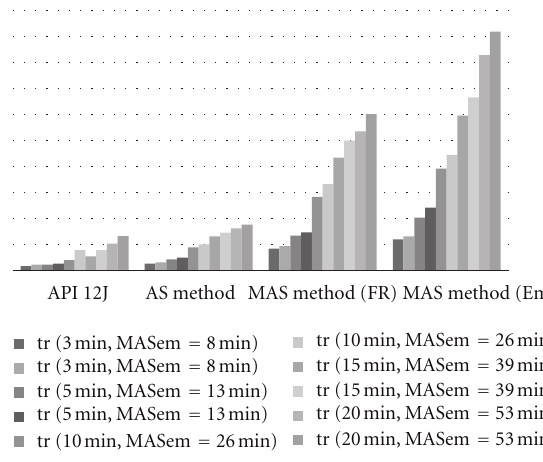
Figure 8: Pareto chart of sizes obtained from di ff erent methods.